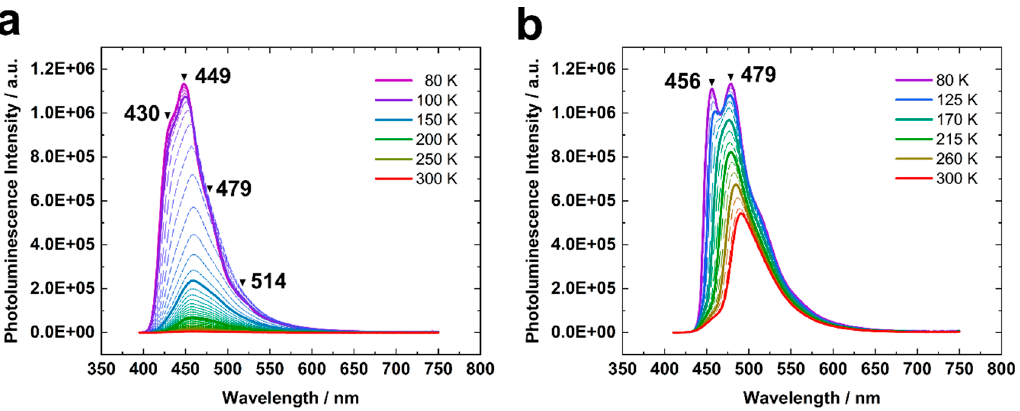
Figure 3. Temperature dependence of photoluminescence spectra of ( a ) the solution and ( b ) the crystals. Temperature increments were 5 and 15 K for the solution and the crystalline samples, respectively.